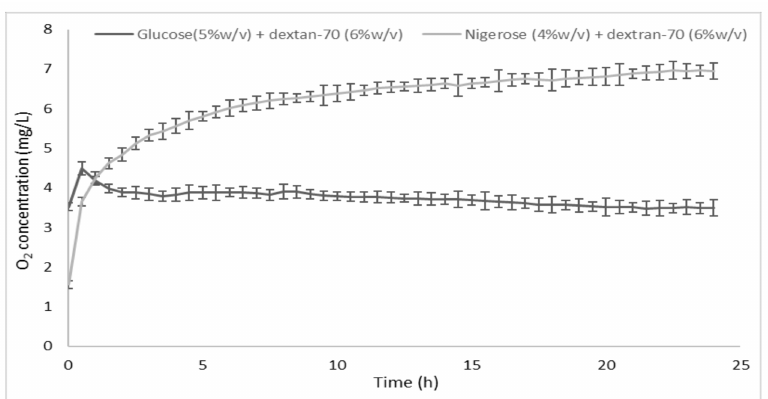
Figure 3. In vitro oxygen release kinetics from the oxygen-loaded cyclic nigerosyl-nigerose glycerol solution containing dextran-70 (6% w / v ), compared to a 5% w / v glucose solution containing dextran- 70 (6% w / v